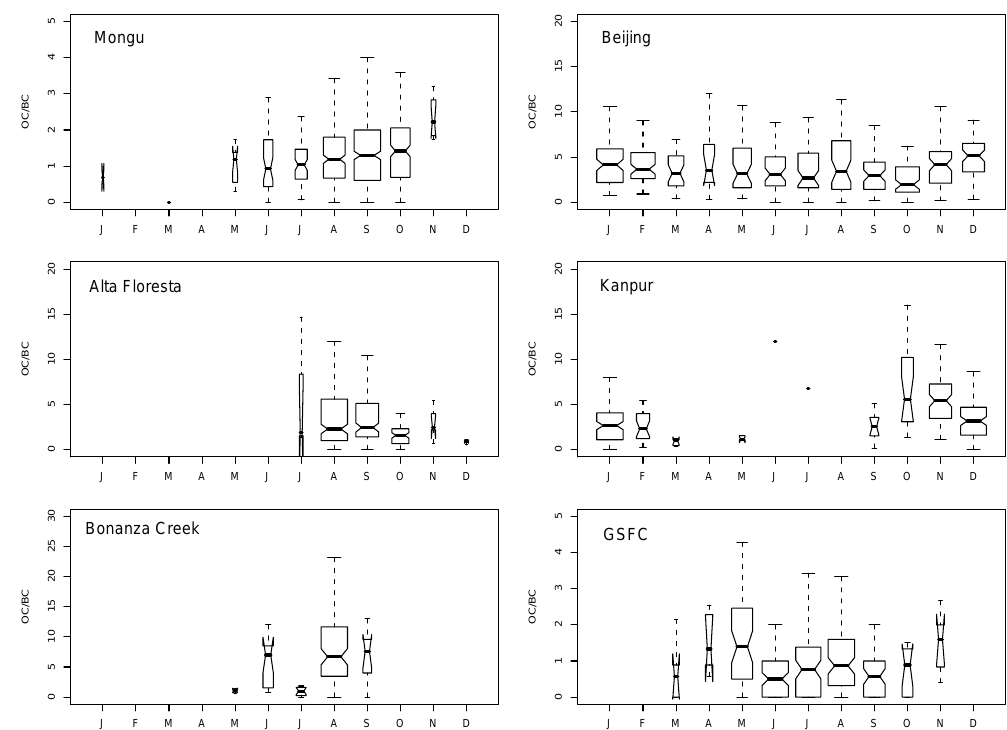
Fig. 4. Boxplot of monthly absorbing OC/BC ratio for the following sites: Mongu, Beijing, Alta Floresta, Kanpur, Bonanza Creek, and